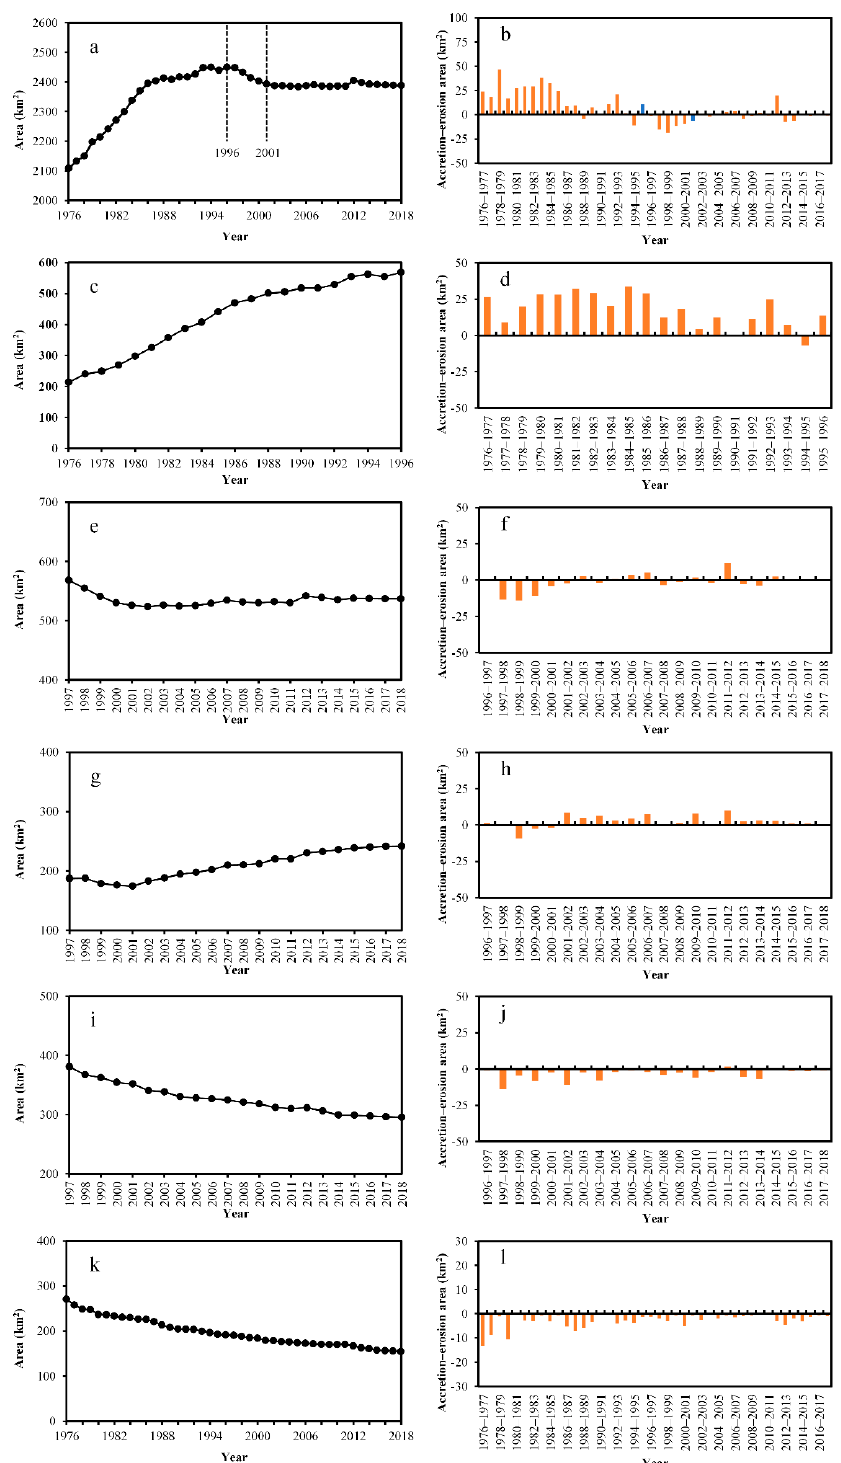
Figure 5. Changes in the land area and accretion–erosion area of the Yellow River Delta (YRD), Yellow River Estuary (YRE), abandoned Qingshuigou estuary, and the northern coast during the different periods. ( a , b ) for the YRD from 1976 to 2018; ( c , d ) for the Yellow River Estuary during the period of the Qingshuigou course from 1976 to 1996; ( e , f ), ( g , h ), and ( i , j ) for the Yellow River Estuary, Qing 8 estuary, and abandoned Qingshuigou estuary during the period of the Qing 8 course from 1997 to 2018, respectively; ( k , l ) for the northern coast from 1976 to